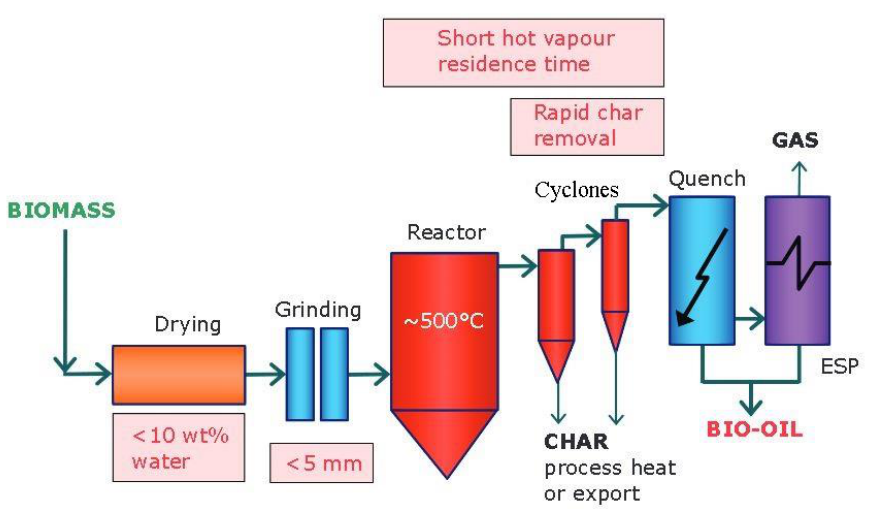
Figure 1. Typical scheme for production of bio-oil via fast pyrolysis [27].